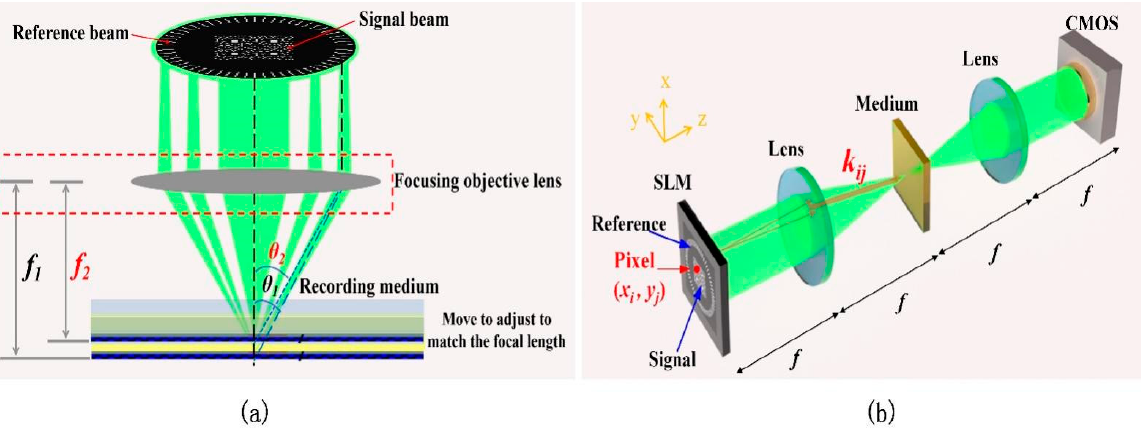
Figure 2. The illustrations of ( a ) the principle for the focal length compensation in the collinear holo- graphic storage system, and ( b ) the simplified optical path of the collinear holographic storage